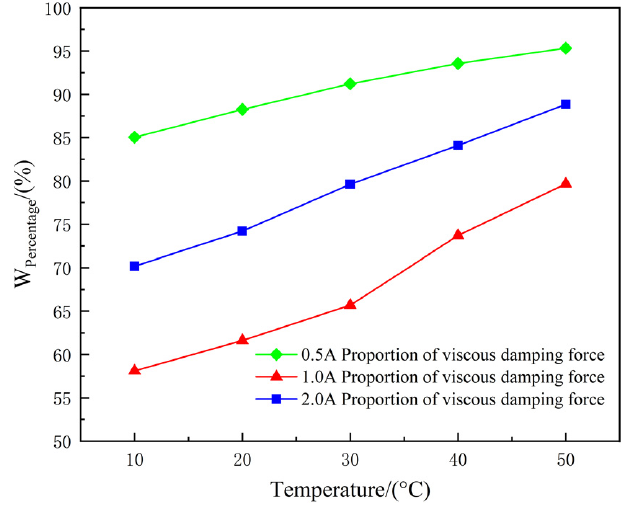
Figure 20. Effect of temperature on viscous damping ratio under impact conditions.